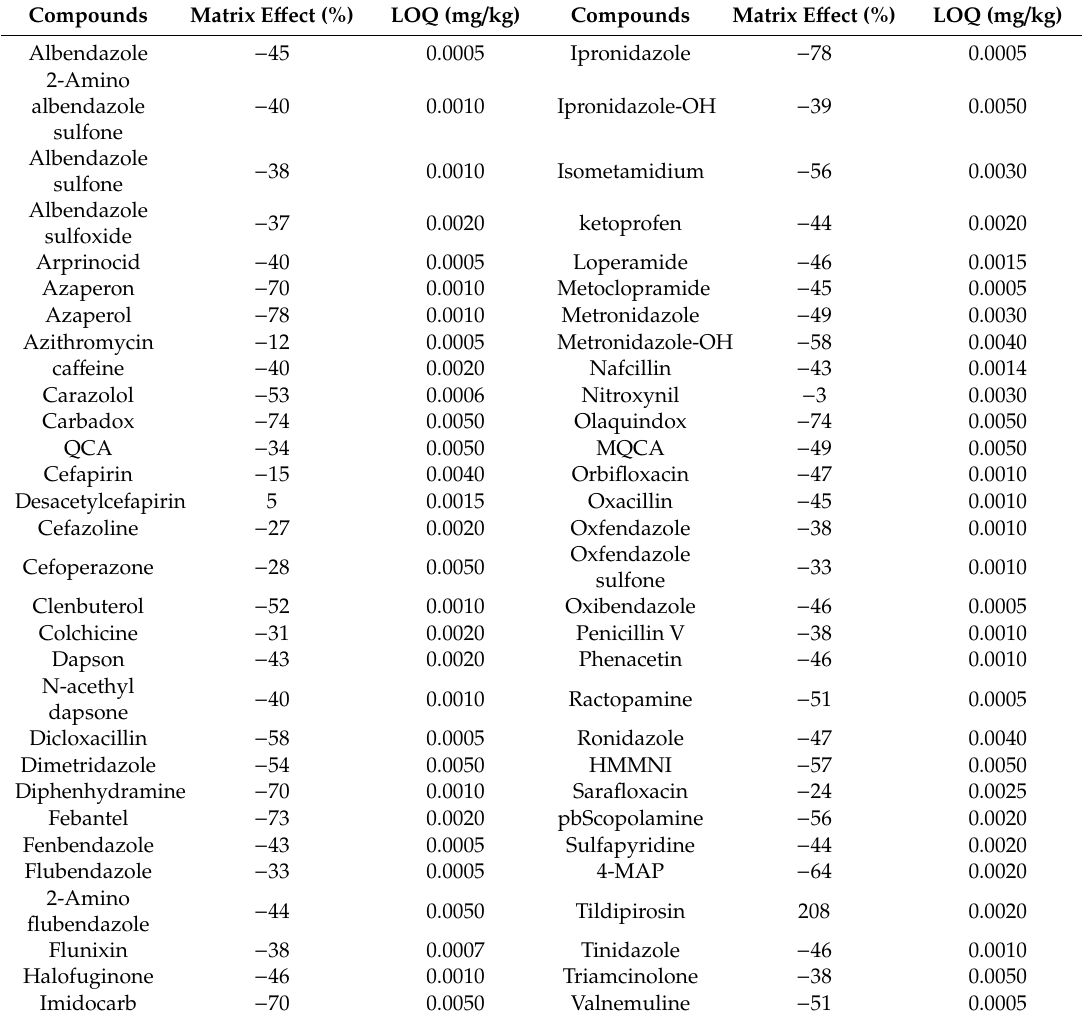
Table 4. Matrix e ff ects (%) and limit of quantification (LOQ) in